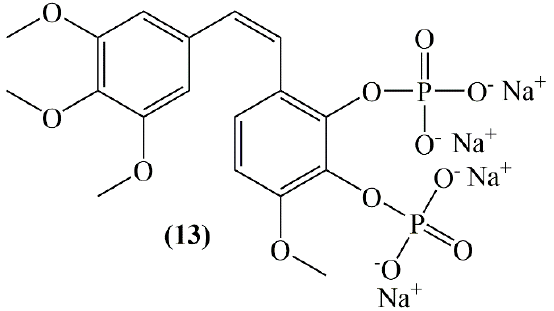
Figure 5. Structure of combretastatin A-1 phosphate ( 13 ).